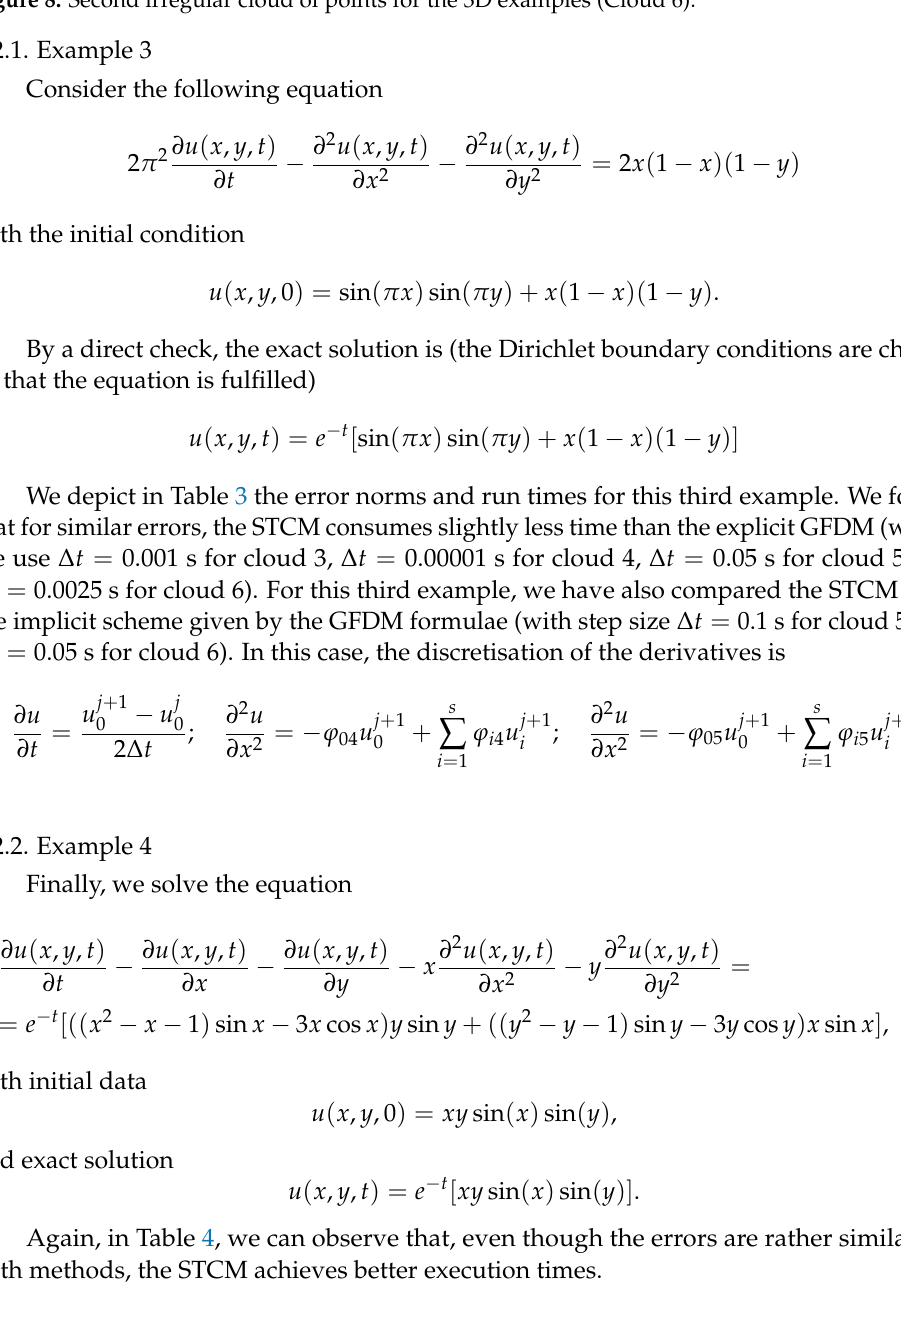
Figure 8. Second irregular cloud of points for the 3D examples (Cloud